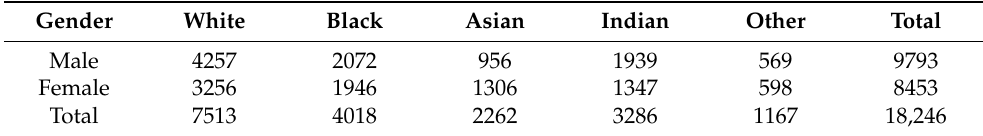
Table 5. Overview of image distribution in UTKFace filtered